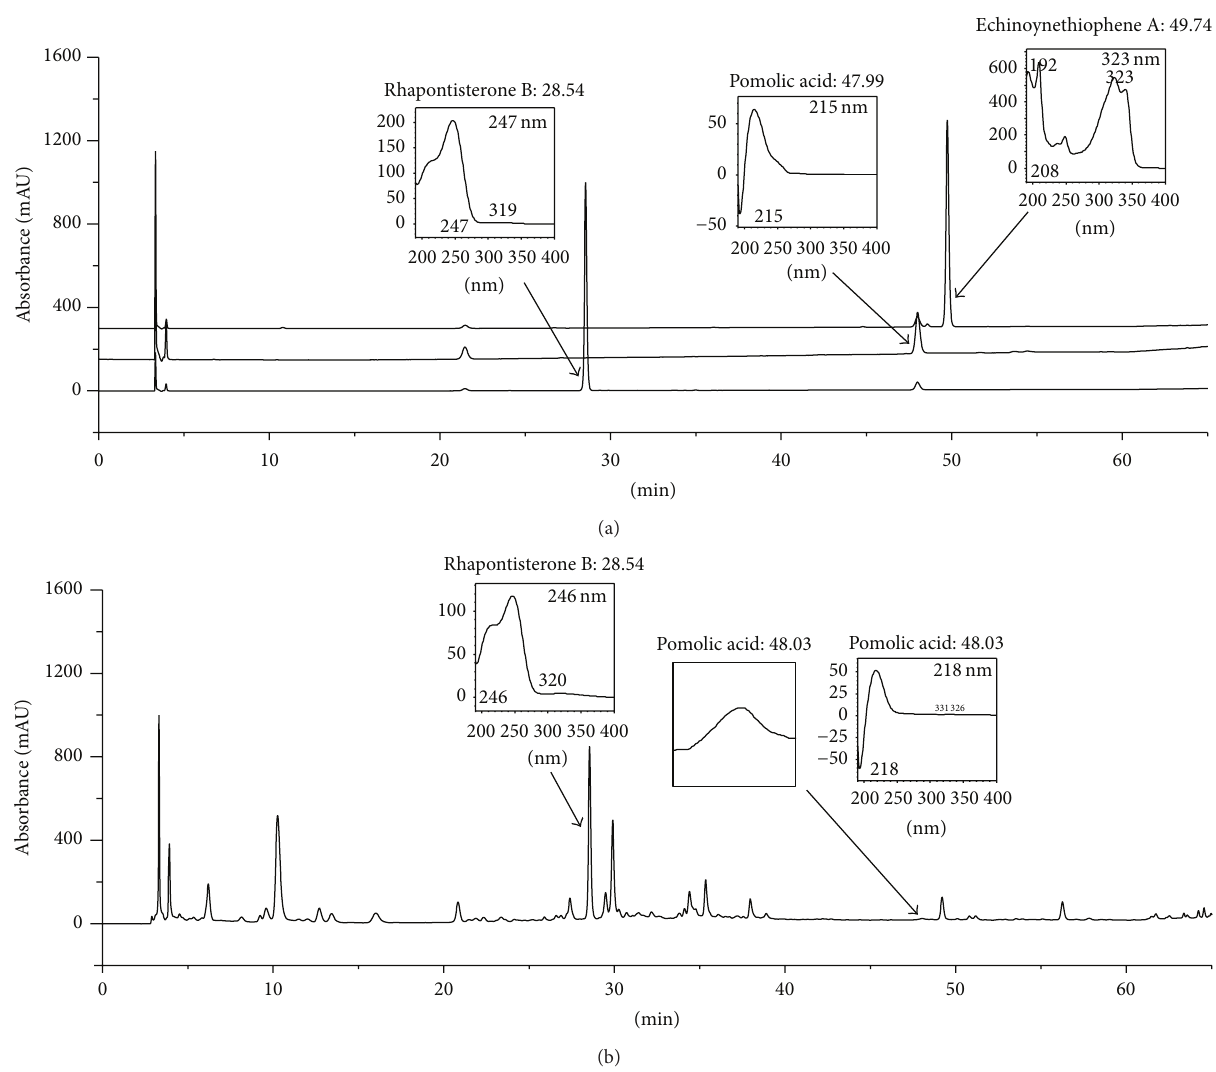
Figure7:HPLC-DADanalysisoftheconstituentsinRR.RhapontisteroneB,pomolicacid,andechinoynethiopheneAin(a)standardmixture and (b) RRE were identified at 254